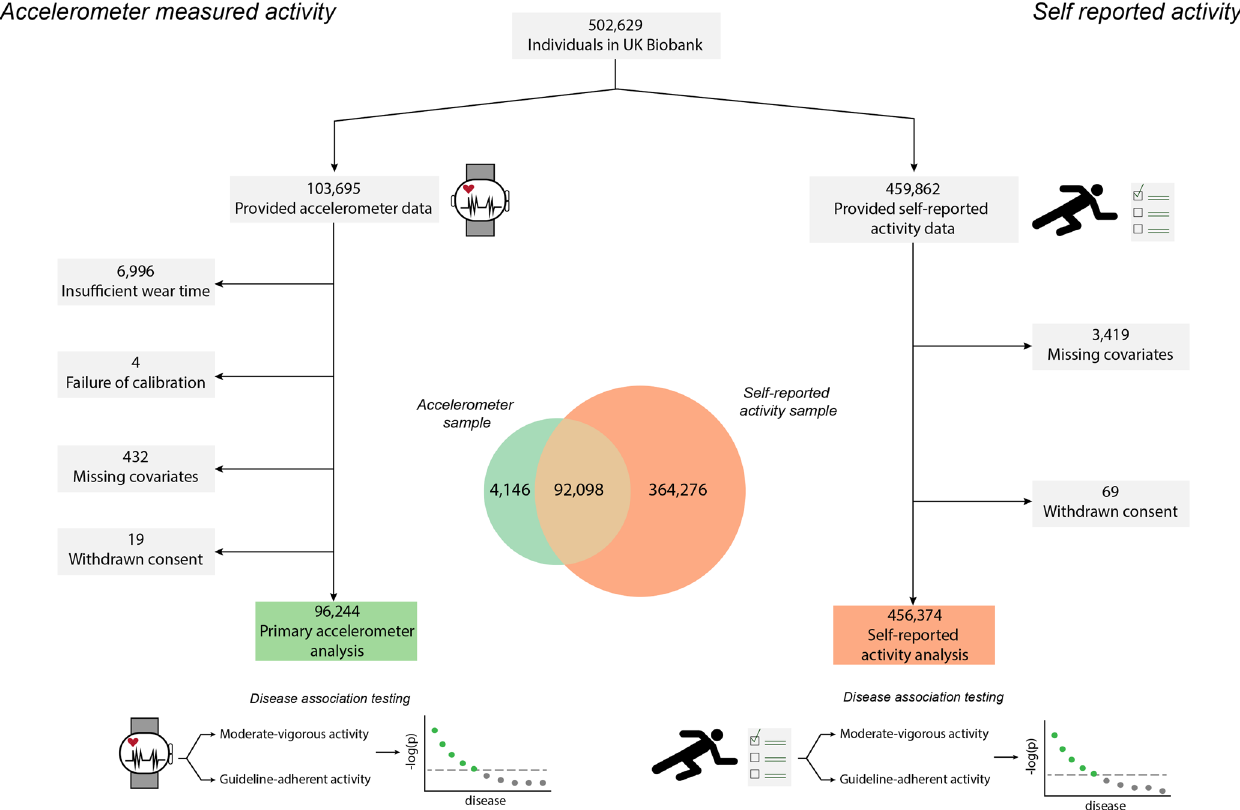
Fig. 1 Study overview. Depicted is a graphical overview of the study. Within 96,244 UK Biobank participants who wore a wrist-worn accelerometer for one week, we tested for associations between objectively measured moderate-to-vigorous physical activity and 697 incident diseases. We performed analogous association testing in 456,374 UK Biobank participants who provided self-reported activity data. There was overlap between the two analysis samples, as depicted by the Venn diagram in the